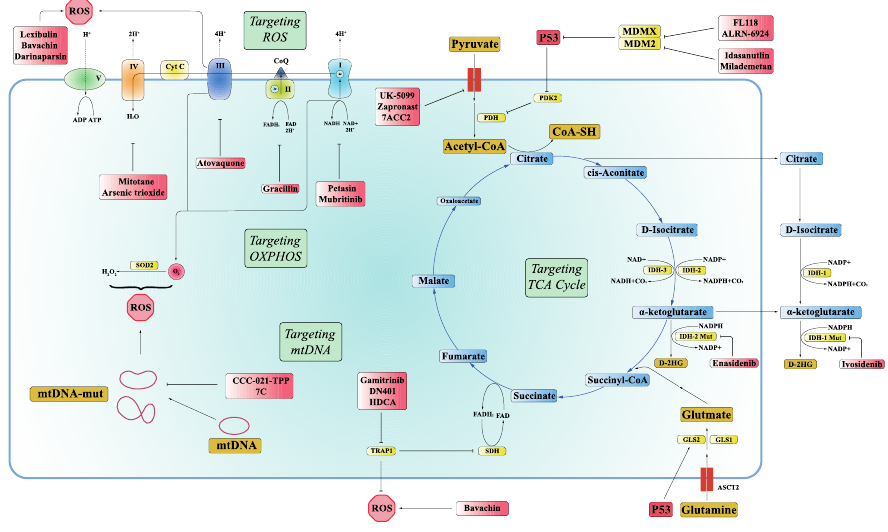
Figure 2. Therapeutic strategies targeting mitochondrial metabolic reprogramming. According to the functional characteristics of mitochondria, current therapies targeting mitochondria can be divided into targeting the TCA cycle, OXPHOS, ROS, and mtDNA. Small molecule compounds developed for the above targets can precisely inhibit the occurrence and progression of cancer by interdicting the normal functioning of mitochondria. (D-2HG, D-2 hydroxy-glutarate; GLS2, glutaminase 2; GLS1, glutaminase 1; HDCA, Honokiol bis-dichloroacetate; IDH, isocitrate dehydrogenase; NAD + , nicotinamide adenine dinucleotide; NADH, nicotinamide adenine dinucleotide; OXPHOS, oxidative phosphorylation; PDH, pyruvate dehydrogenase; PDK2, pyruvate dehydrogenase kinase 2; ROS, reactive oxygen species; SDH, succinate dehydrogenase; TRAP1, Tumor necrosis factor receptor-associated protein 1.).